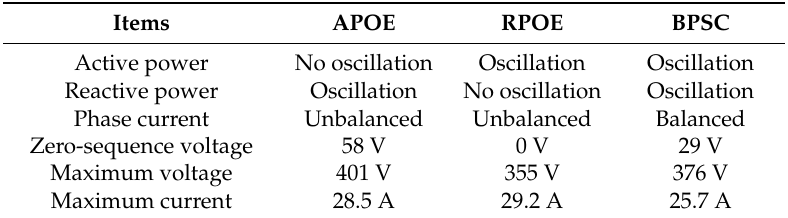
Figure 10. Experiment results of star-connected SVG. APOE in the left. RPOE in the middle. BPSC in the right. ( a ) Grid voltages. ( b ) Active and reactive power. ( c ) Phase currents of SVG. ( d ) three-phase voltage amplitudes. ( e ) Sub-module capacitor voltages of each phase cluster. ( f ) Zero-sequence voltages. Table 3. Comparison of three strategies.